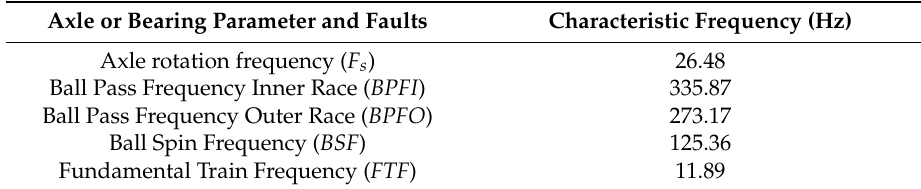
Table 1. The bearing characteristic frequencies at 270 km/h.